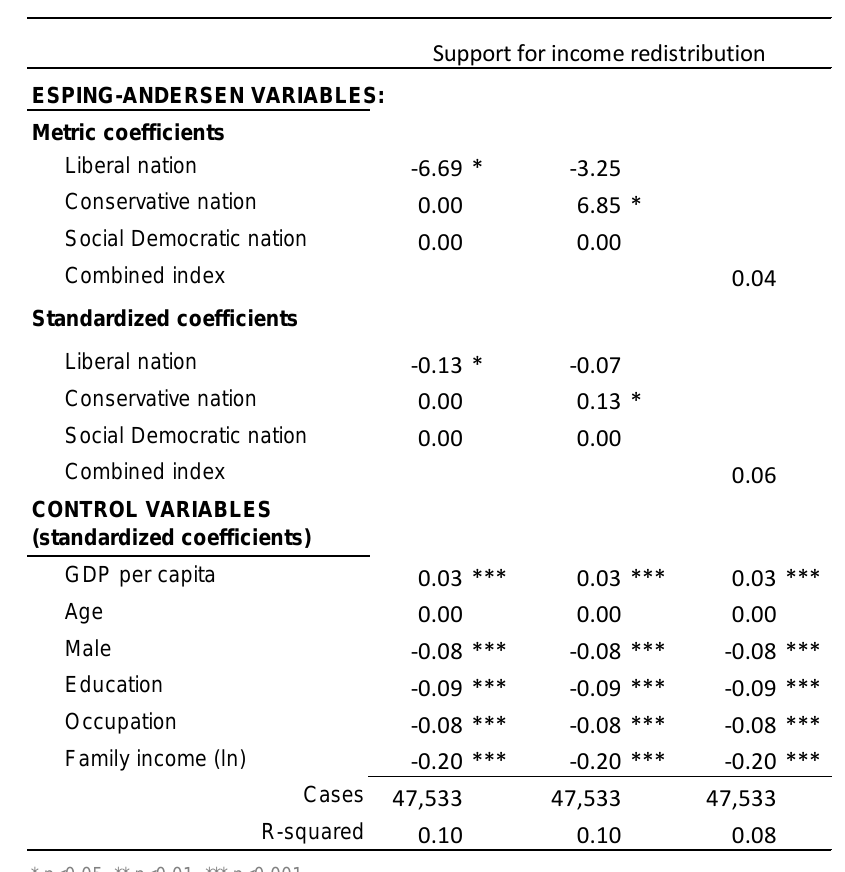
Figure A2. Measuring and creating a variable to impute corporatism. Inter-item correlations, correlations with criterion variables, and unrotated factor loadings.